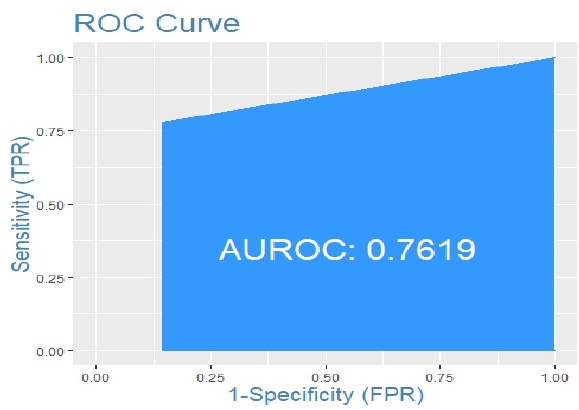
Figure 10. Area under ROC curve for CART